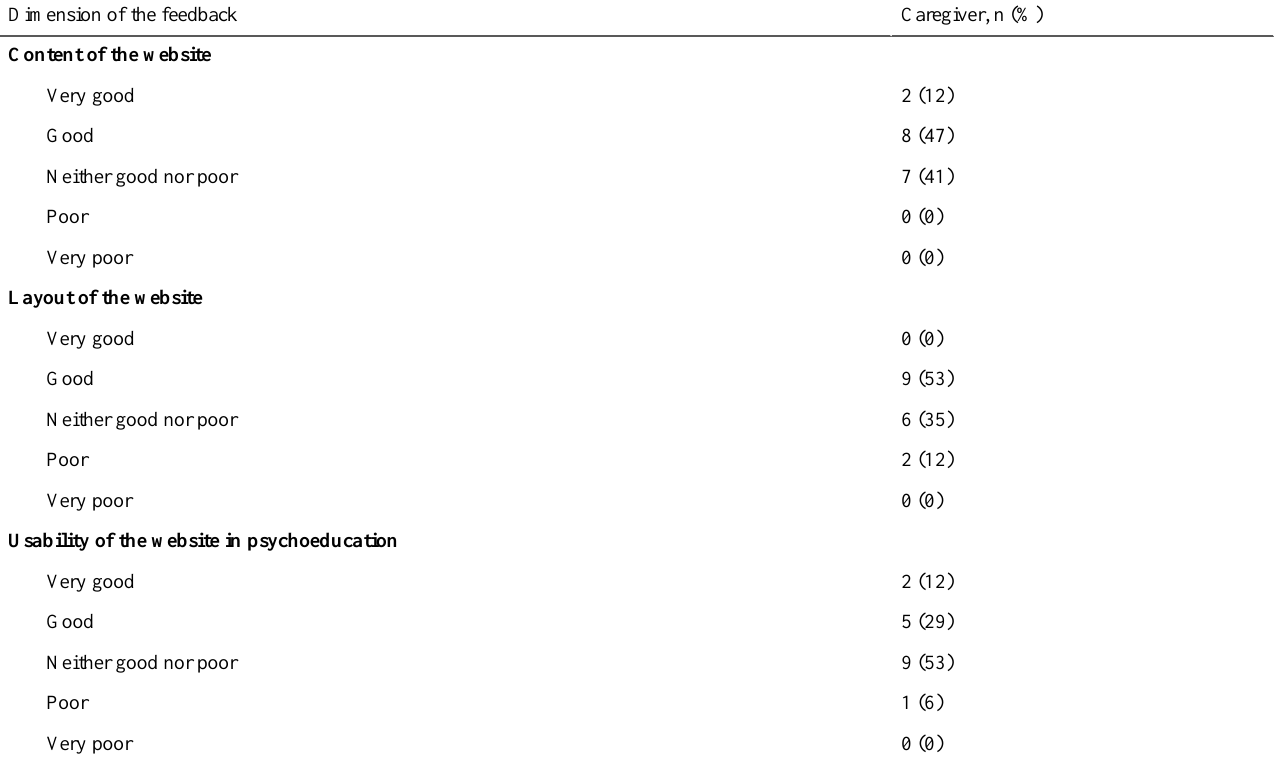
Table 4. Feedback about content, layout, and usability